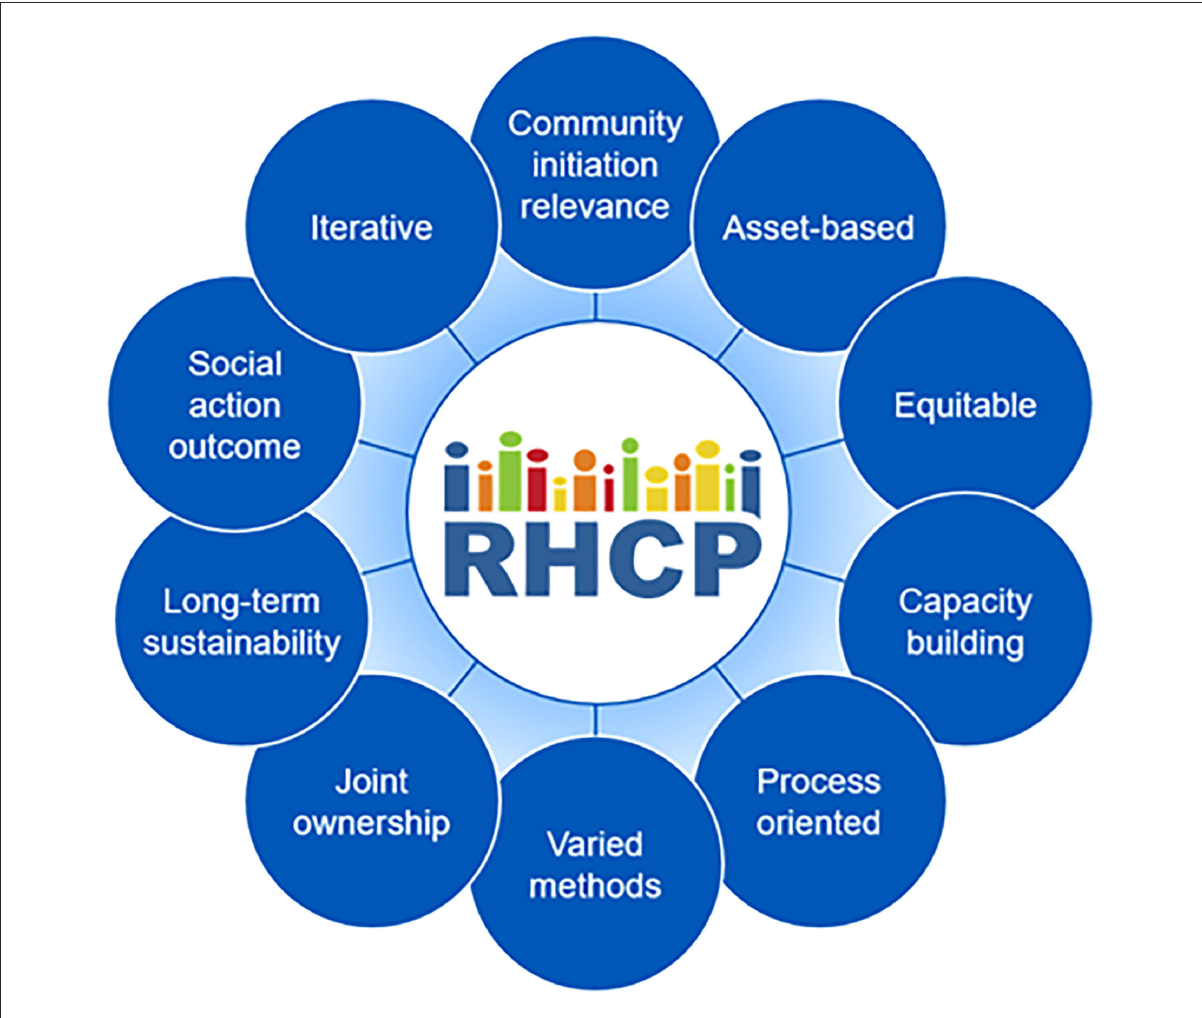
FIGURE1 RHCP CBPR principles.